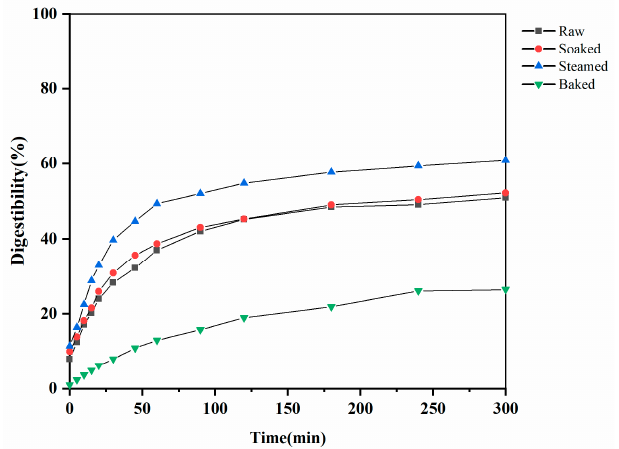
Figure 6. Starch digestion curves of M1 with different processing treatments.